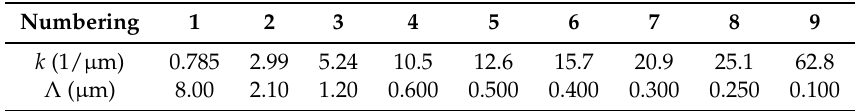
Table 2. Summary of the spatial frequencies/periods of the initial modulation considered in the numerical